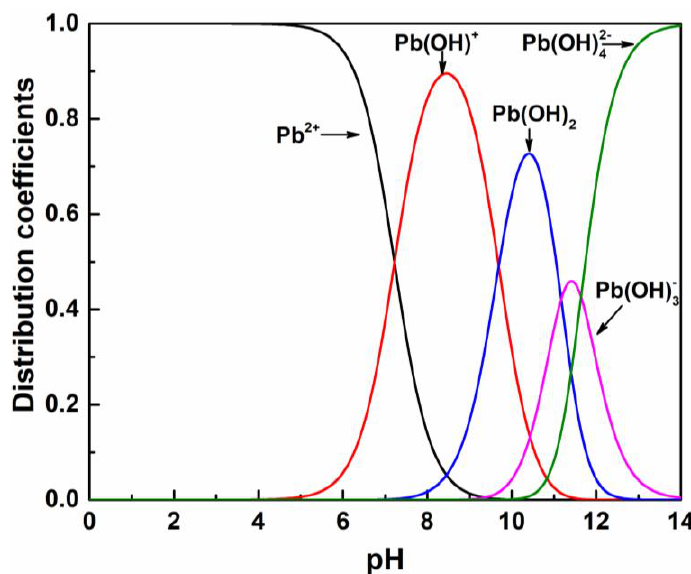
Figure 6. Distribution coefficients of various lead hydroxyl complexes in aqueous. solutions as a function of pH [23].